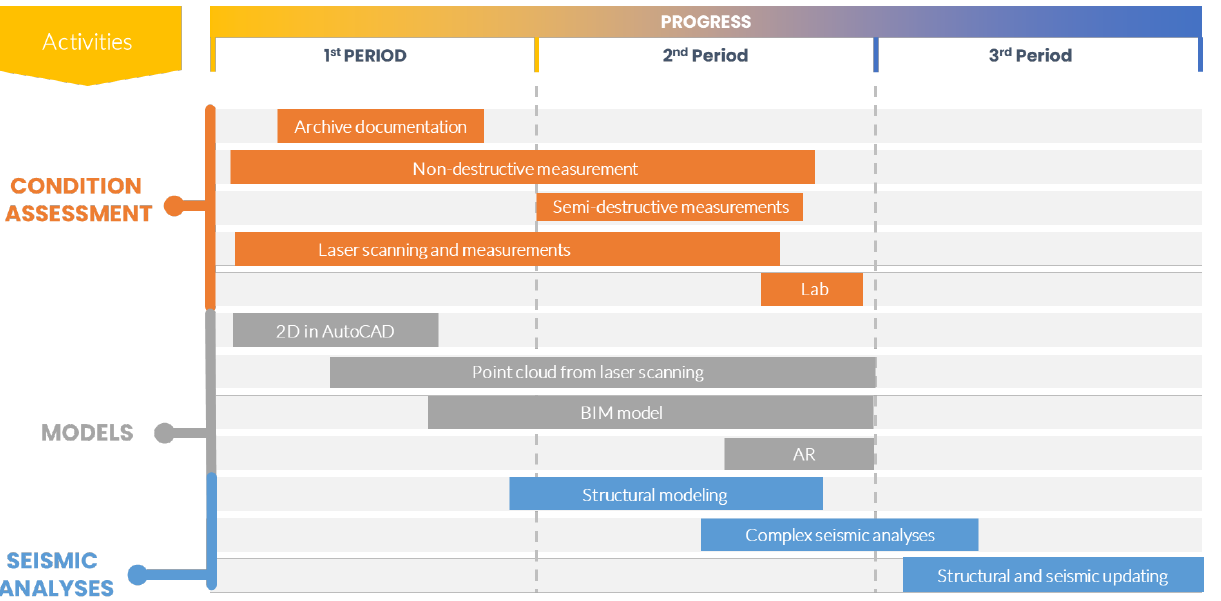
Figure 3. Obtained activities for the assessment of case study building (AR = augmented reality).